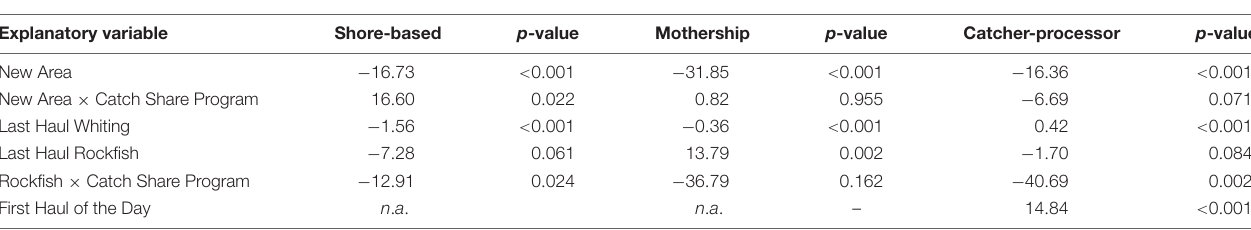
TABLE 4 | Fixed effect models of haul duration by